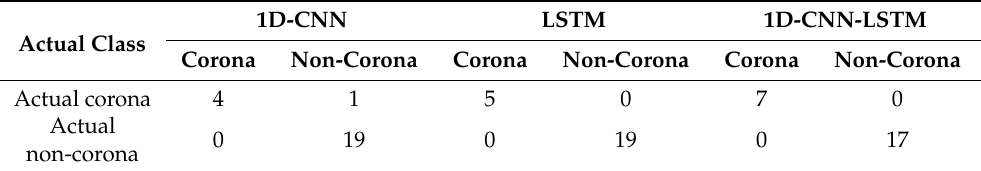
Table 11. Frequency domain corona fault classification output matrix for the validation phase.